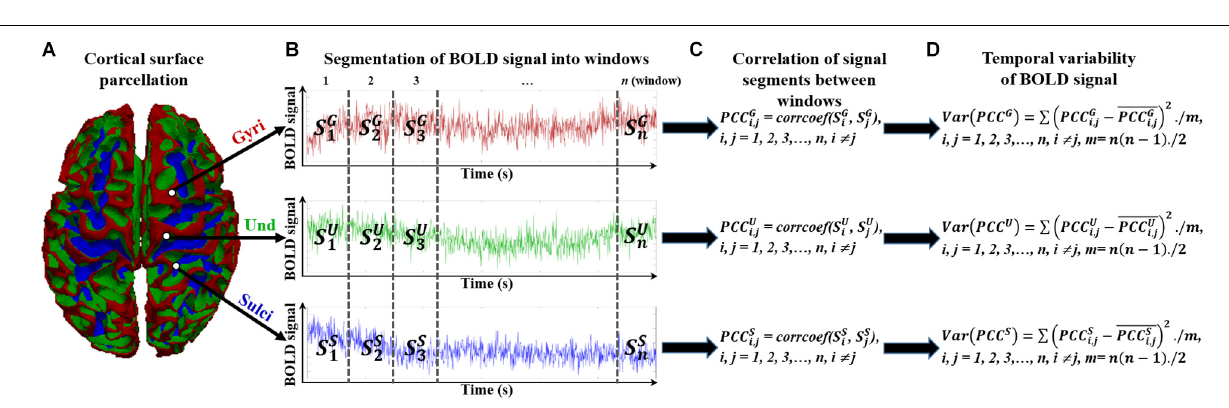
FIGURE 2 | Temporal variability assessment of functional activity in cortical gyri, sulci, and undefined regions. (A) The parcellated cortical surface of gyri, sulci, and undefined regions. (B) Segmented n non-overlapping time windows of each BOLD signal in gyri, sulci, and undefined regions. (C) Assessment of correlation between any pair of signal segments in time windows. (D) Assessment of variance of all correlation values between time window